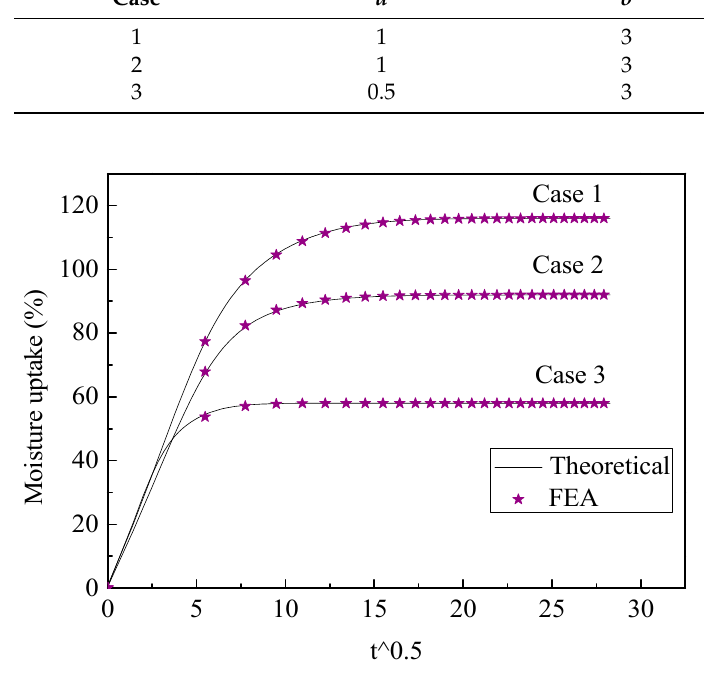
Figure 11. FEA and theoretical calculation of the whole unit cell.